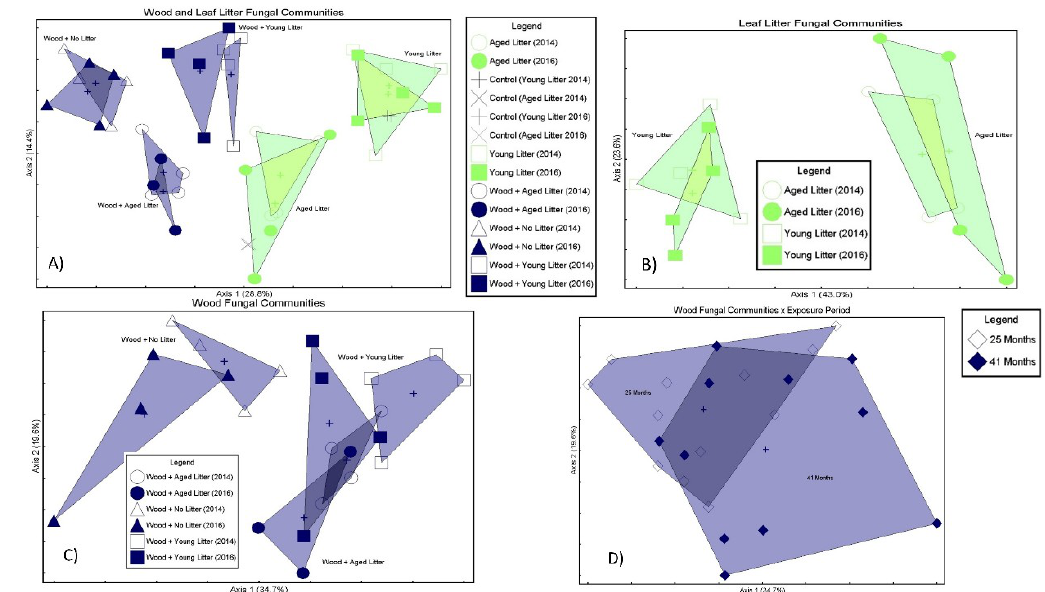
Figure 5. NMDS ordinations depicting: ( A ) Similarity between wood fungal communities exposed to aged (A), young (Y), or no leaf litter (N); ( B ) similarities between all treatment groups: unexposed controls (lf14-lf16HM (young) and lf-16SB (aged) compared to exposed leaves leaf14–16Y (young) and leaf14–16A (aged) and finally wood exposed to either young (Y) or aged (A), as well as no litter (N). ( C ) All samples grouped, overall similarity between fungal communities at the two exposure periods 2014 (25 months) and 2016 (41 months), showing similarities in the fungal communities. ( D ) NMDS of fungal communities in litter only showing differences in young (Y) and aged (A) litter that persisted over the two sampling times.